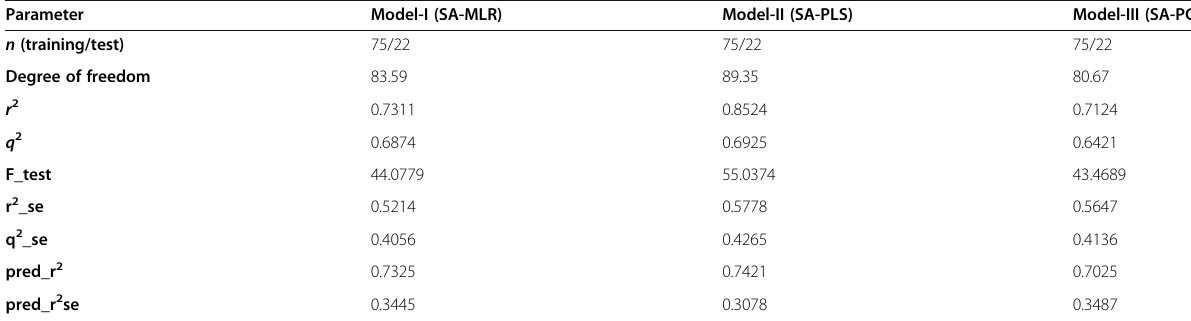
Table 3 Statistical parameters of the developed G-QSAR models Parameter